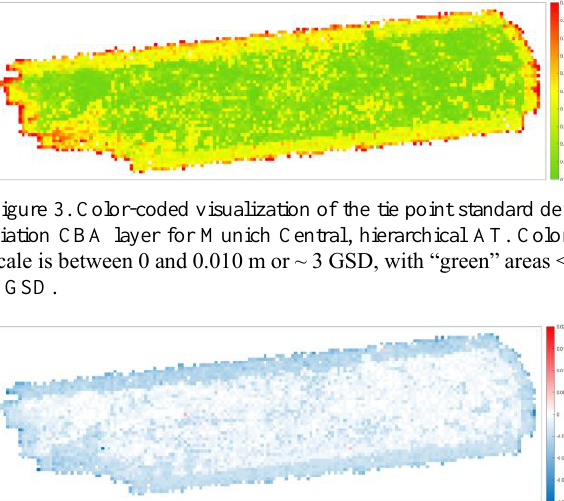
Table 8. Performance of integrated and hierarchical AT runs of the Stillwater block, all values in [mm:ss].